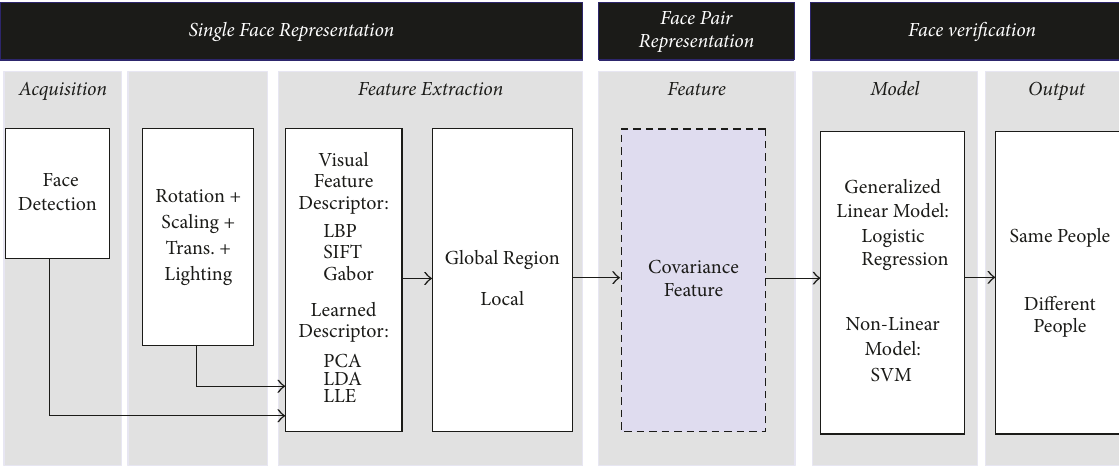
Figure 4: The proposed face verification framework based on the second-order feature representation.